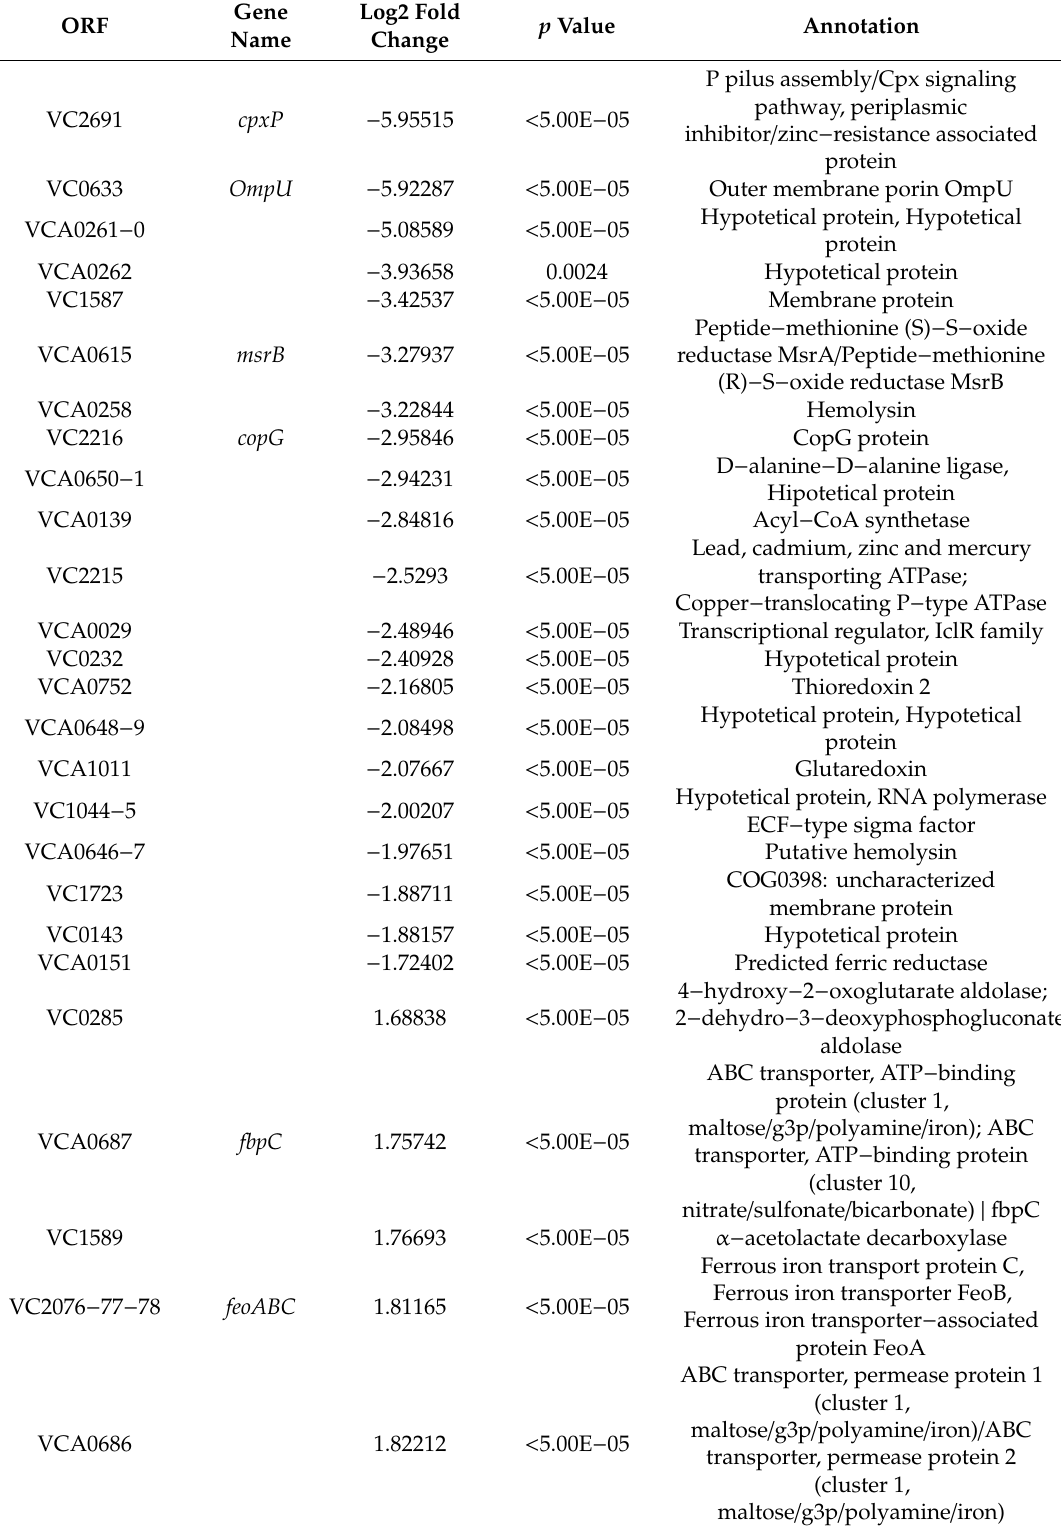
Table 1. Di ff erentially expressed genes in response to the VCA0231 elimination in V. cholerae